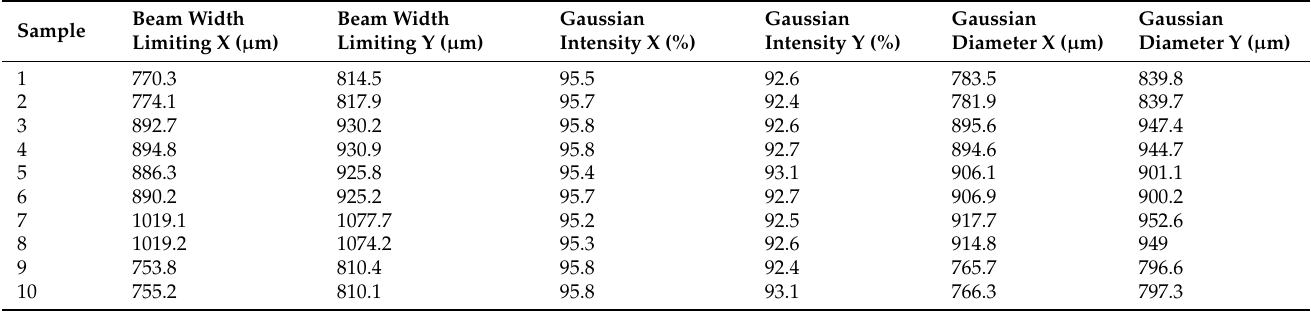
Figure 10. Beam quality of 3D. The 3D spatial power energy distribution of LD TO are tested by 3D beam analyzer. ( a ) is the beam quality of 3D shown in Figure 9a, and ( b ) is the beam quality of 3D shown in Figure 9b. Table 3. Data of beam